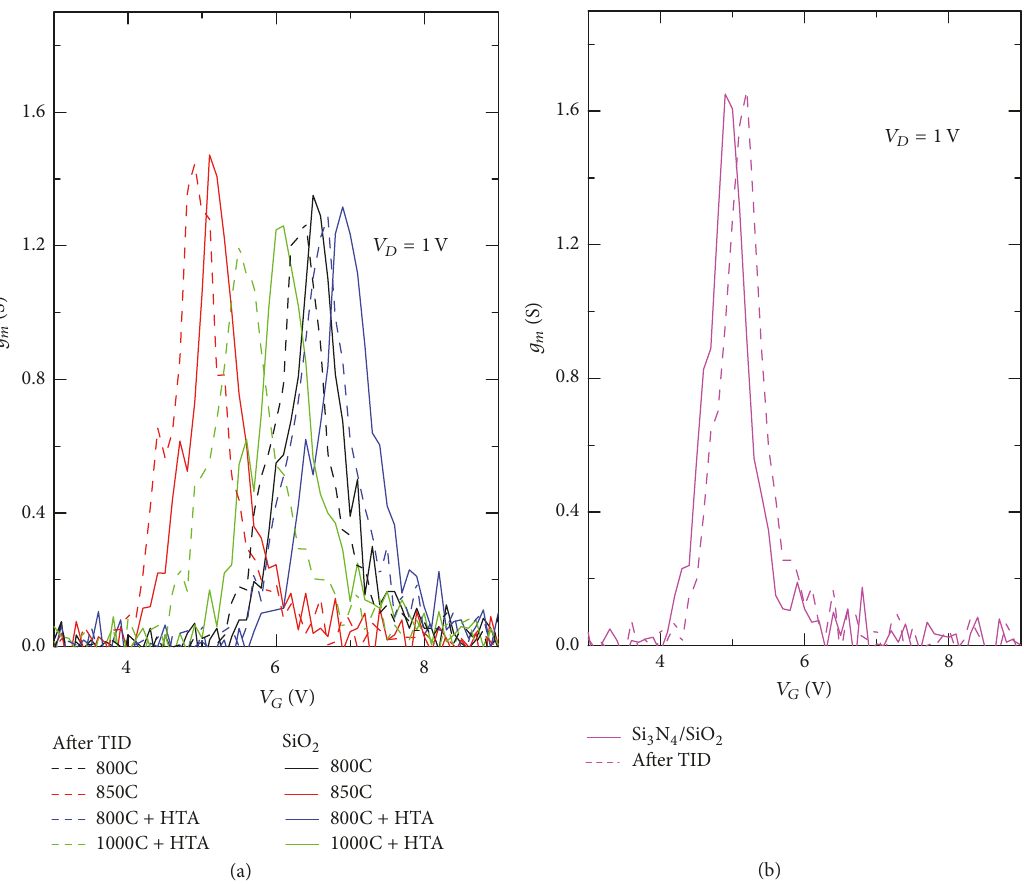
Figure2: 𝑔 𝑚 - 𝑉 𝐺 characteristicsofSiVDMOSwithdifferentgatedielectricsanddifferentoxidationconditionsbeforeandafterTIDirradiation with 𝑉 𝐺 = 10V (solid line: before irradiation; dashed line: after TID irradiation).